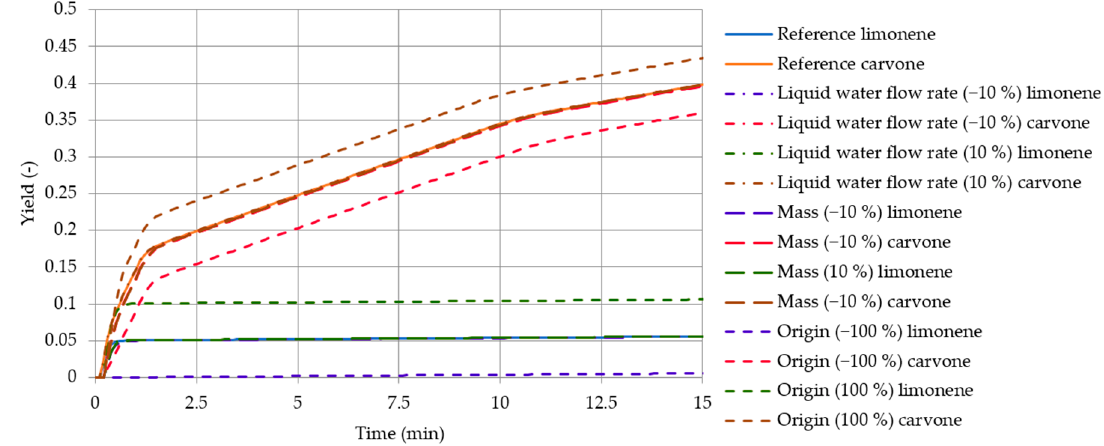
Figure 9. One-parameter-at-a-time study.